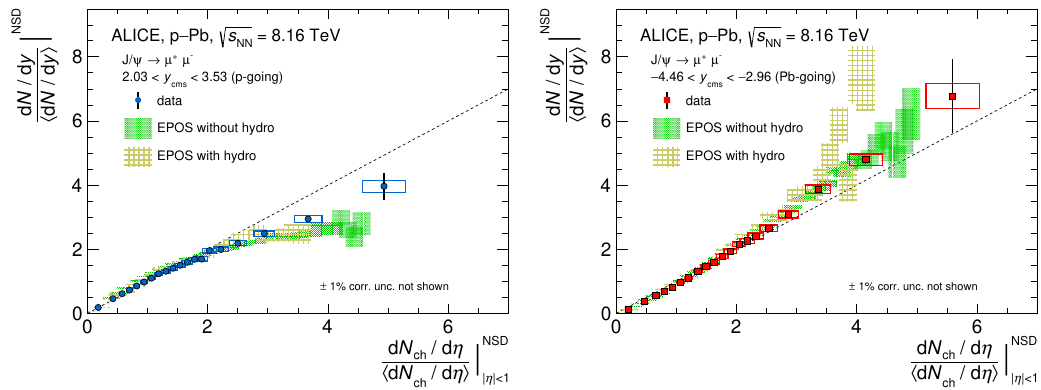
Figure 5 . Normalized yield of inclusive J = as a function of the normalized charged-particle pseu- p dorapidity density, measured at midrapidity, in p-Pb collisions at s NN = 8 : 16 TeV compared with EPOS 3 [60, 61] calculations. Left (right) panel presents the measurement at forward (backward) rapidity. The vertical bars represent the statistical uncertainties, the boxes the systematic ones. The dashed line indicates the one-to-one correlation, to guide the eye. The shaded areas represent the statistical uncertainties on the EPOS 3